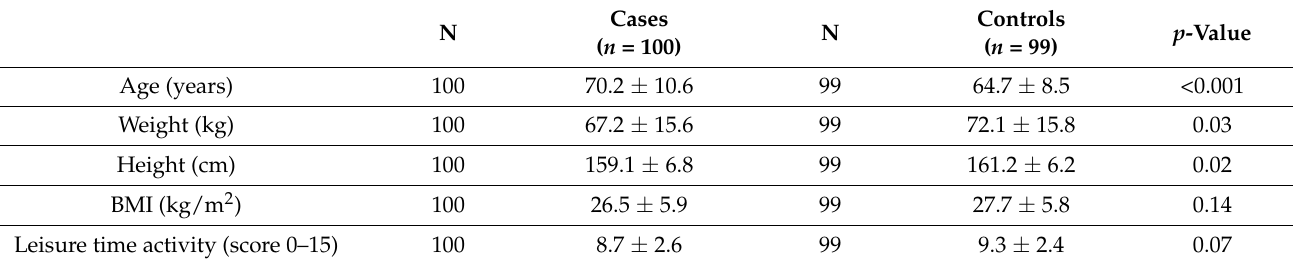
Table 1. Patients’ general characteristics and biochemistry results at